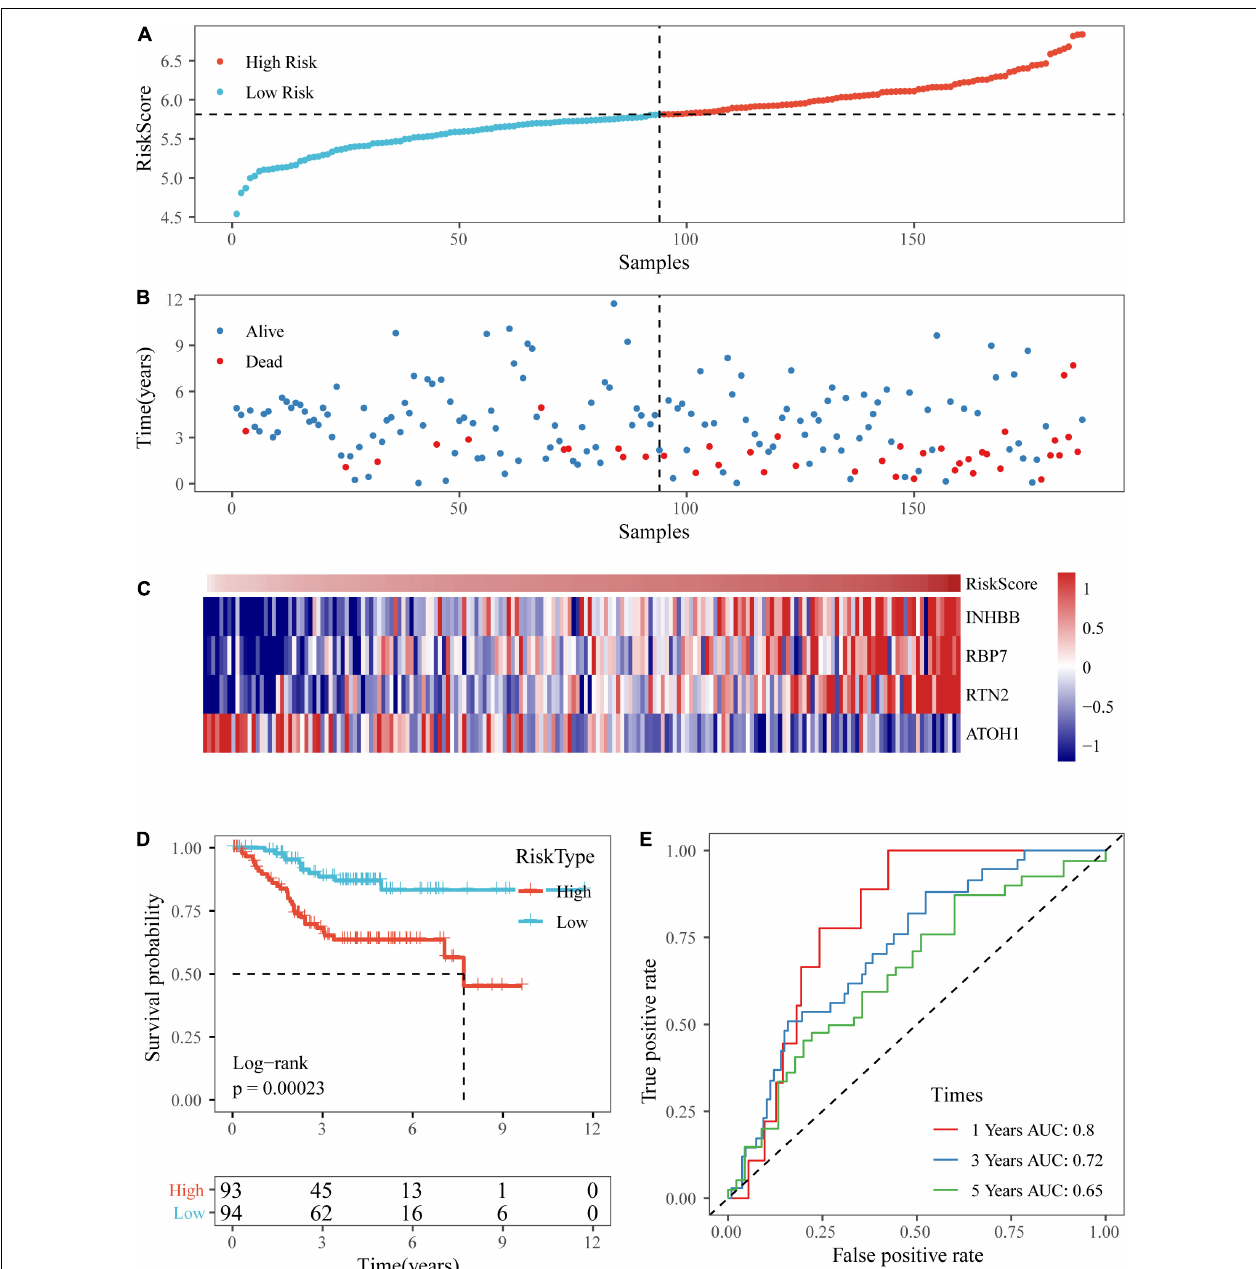
FIGURE 9 | Verification of the four-gene signature in the GSE17538 dataset. (A,B) The distribution of risk scores in the GSE17538 dataset and the distribution of corresponding survival states. (C) Heatmaps of gene expression in the risk score model. (D,E) KM curves and ROC curves of the risk score in the GSE17538